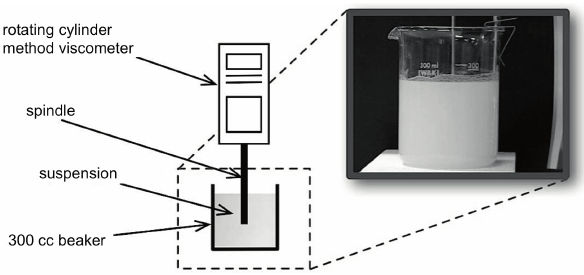
Figure 1. Schematic illustration of the apparatus for viscos- ity measurement at room